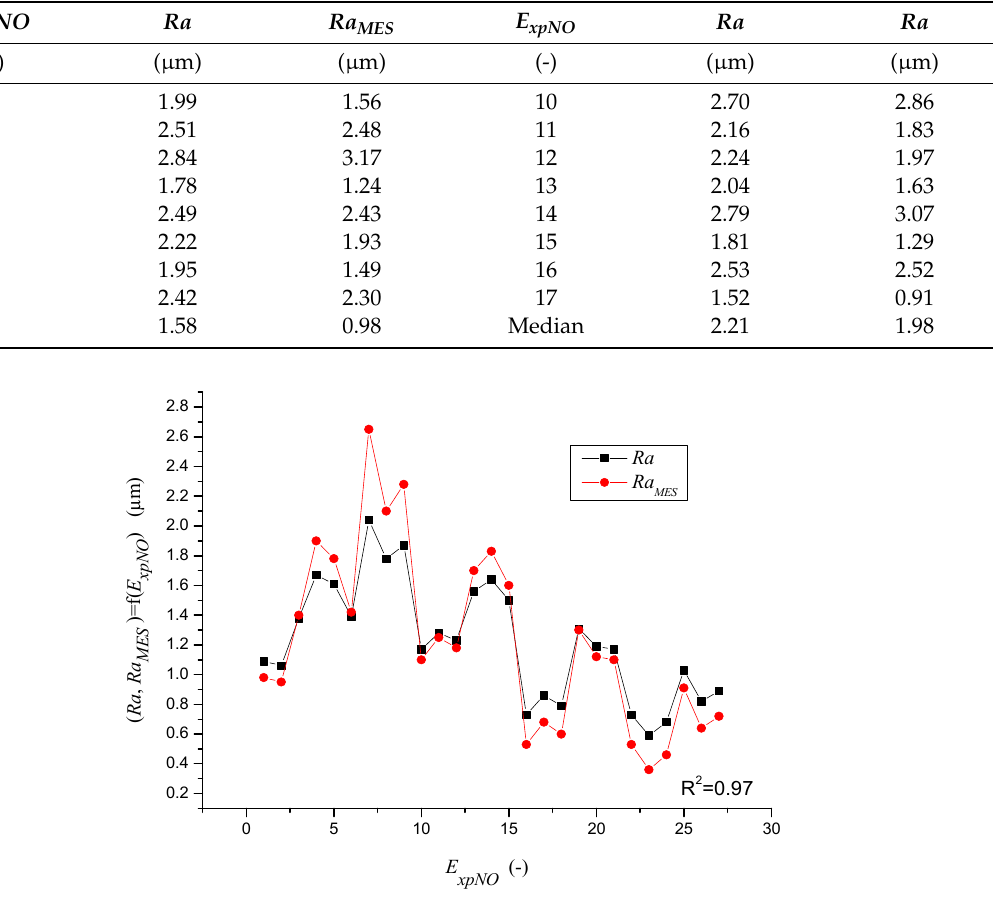
Table 10. Comparison and Verification [7].